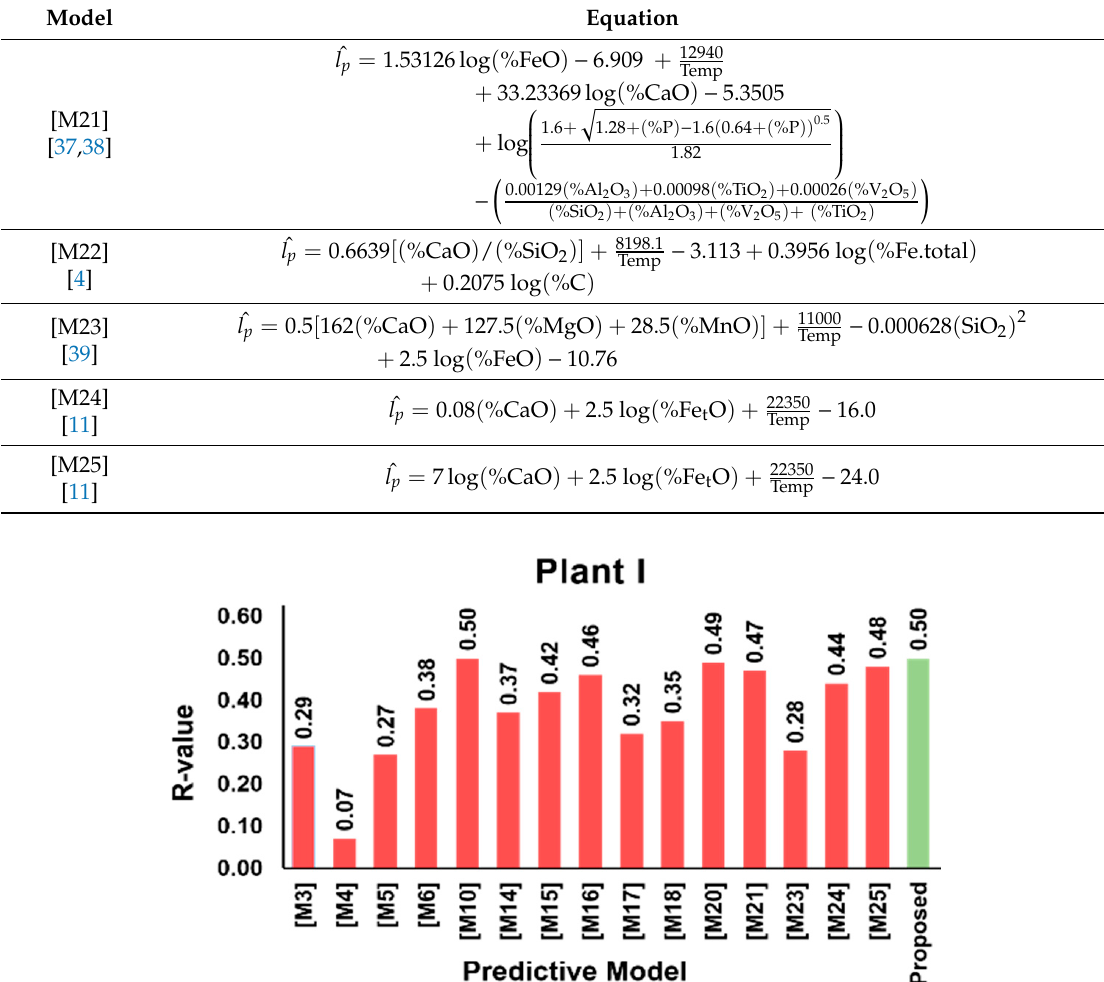
Figure 10. Comparison of R values for existing and proposed models for predicting dephosphorization in steel for Plant I.